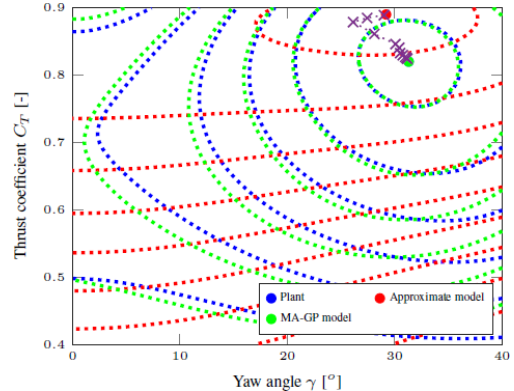
Figure 5. The contour plot of the plant, approximate model and MA–GP model after 10 iterations. The operating points of each it- eration are marked with a